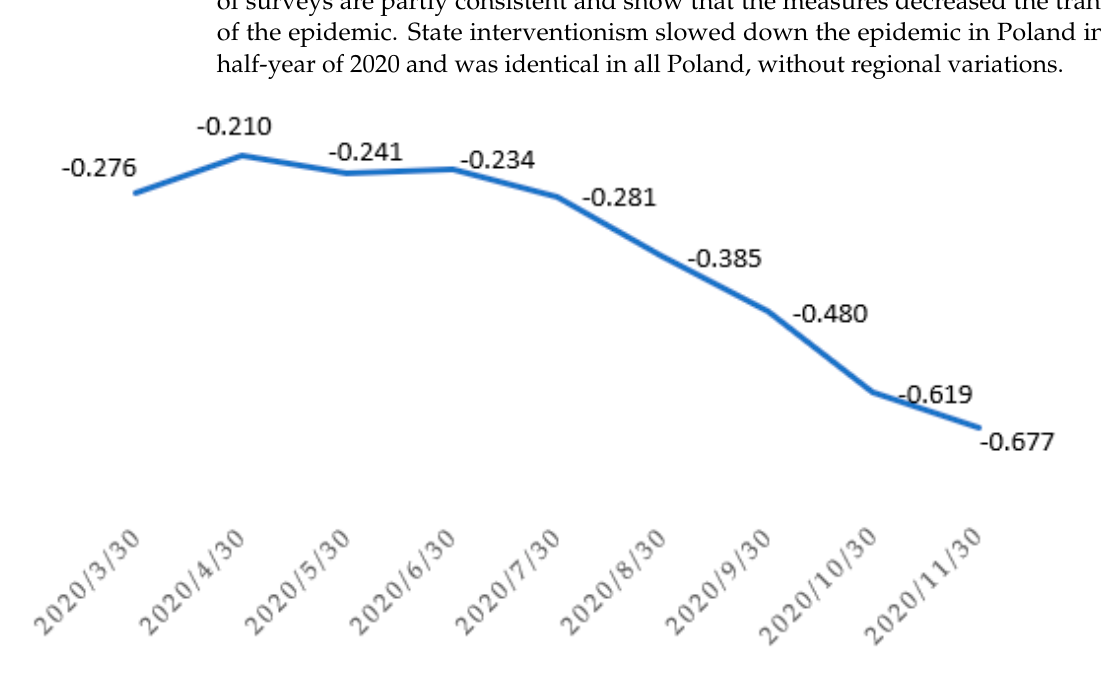
Figure 7. Relationship between the KLE model and the spread of COVID-19 (30.04–30.11.2020). Source: own elaboration